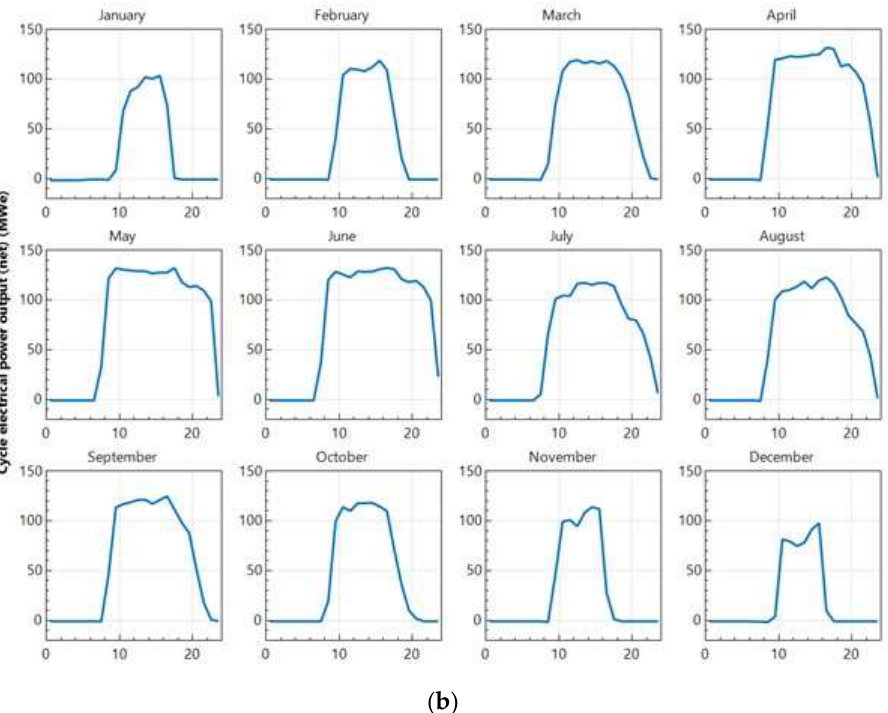
Figure 8. Solana solar facility. ( a ) Computational thermal power produced by half the solar field, half the thermal energy storage power in and out, and thermal power input to half the power cycle. ( b ) Computational net power output from one of the two turbines in the average day of every month. X is the time of the day in hours and Y the power in MW.